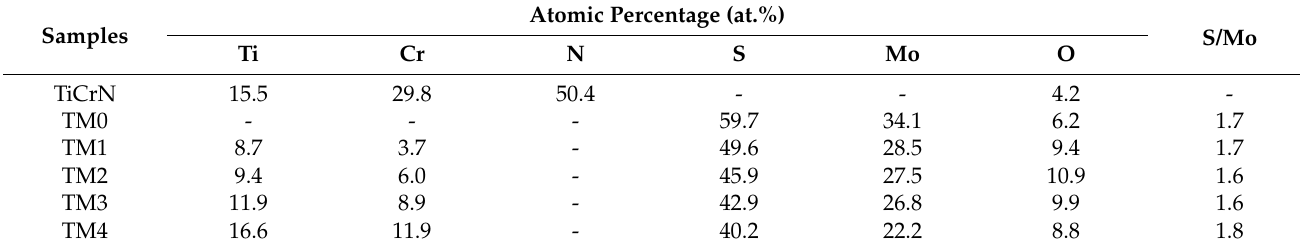
Table 2. The EDS results of TiCrN, MoS 2, and MoS 2 –TiCr layers.